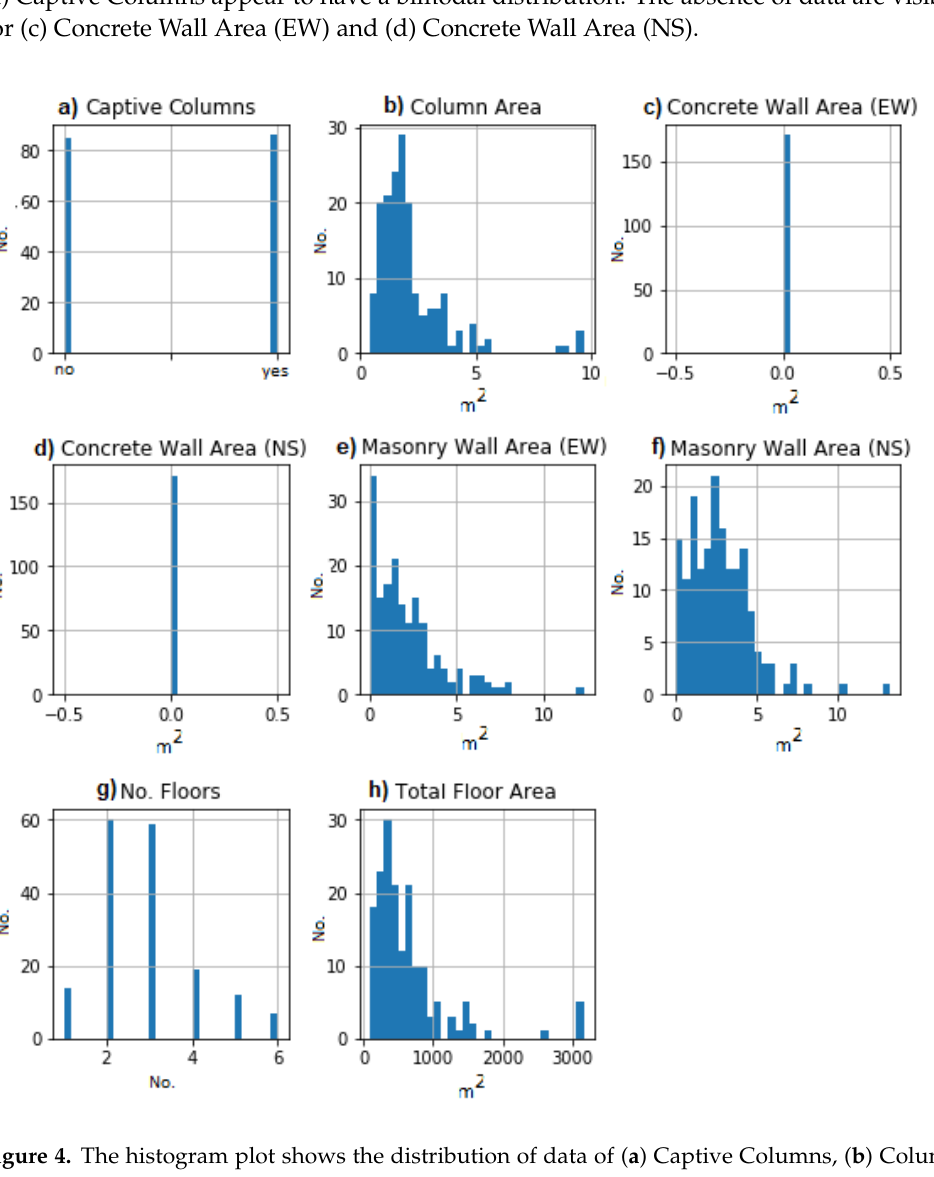
Figure 4. The histogram plot shows the distribution of data of ( a ) Captive Columns, ( b ) Column Area, ( e ) Masonry Wall Area (EW), ( f ) Masonry Wall Area (NS), ( g ) No. of Floor, and ( h ) Total Floor Area for